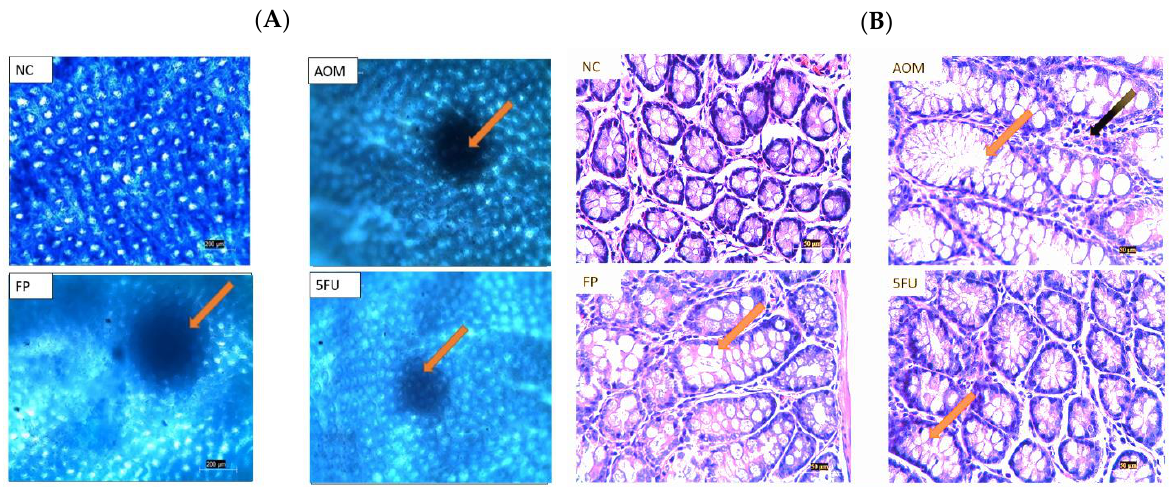
Figure 3. ( A ) Methylene blue stain shows the aberrant crypt foci (ACF), (scale bar= 200 µm). The arrow points to the abnormal crypts that show ACF lesions ( B ) Hematoxylin and eosin (H & E) staining findings of the colon of treated and untreated control groups, (scale bar= 50 µm). The orange arrows show enlarged crypts, while the black arrows point to the inflammatory infiltration. (NC): Normal control, (AOM): Azoxymethane, (FP): F. prausnitzii and (5-FU): 5-fluorouracil.